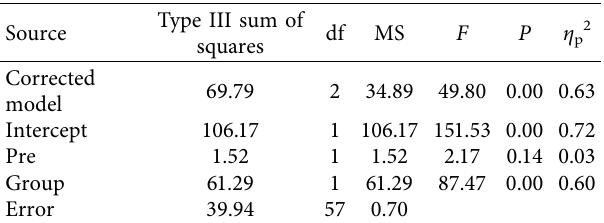
Table 4: Analysis of covariance (ANCOVA) comparing posttest scores across